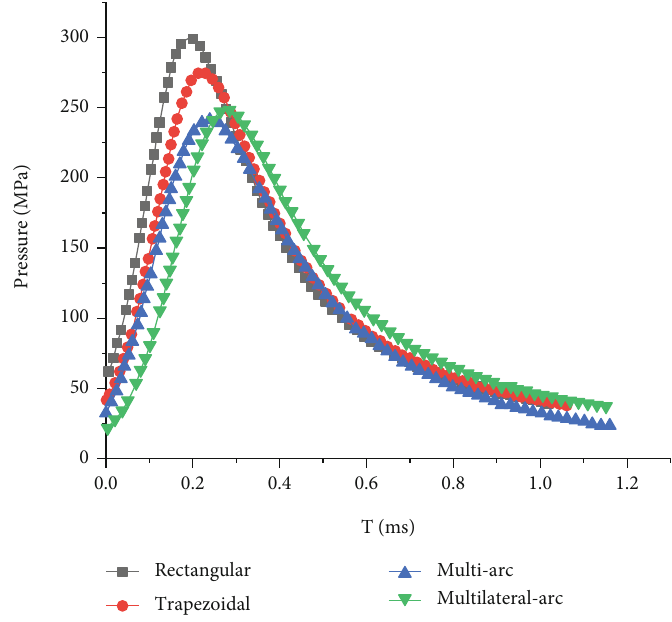
Figure 7: Chamber pressure-time curves.